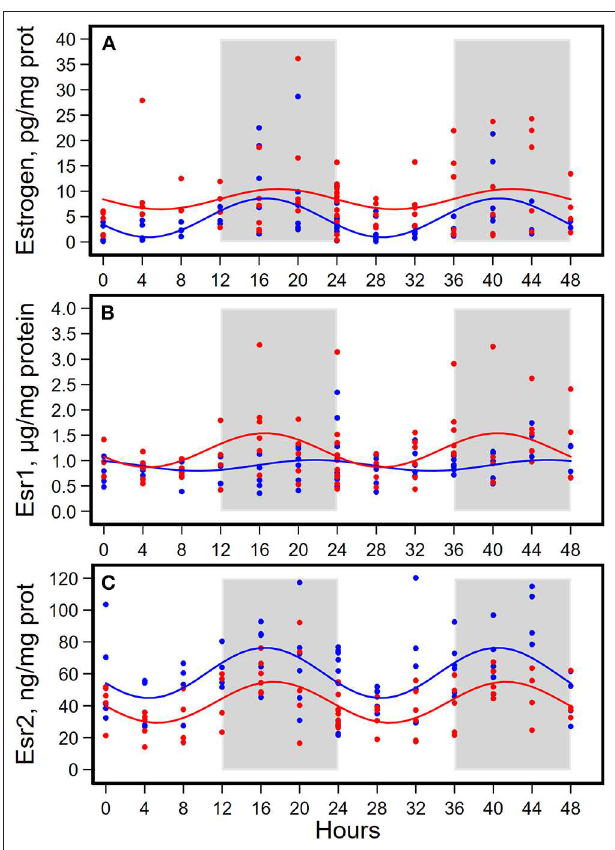
FIGURE 4 | Diurnal expressions of concentrations of estrogen (A) , estrogen receptor 1 (Esr1, B ), and estrogen receptor 2 (Esr2, C ) in mammary glands from pubertal mice fed AIN93G or high-fat diet ( n = 5 per time point per group). Open background: light phase; gray background: dark phase; blue circles and line: AIN93G diet; red circles and line: high-fat diet. The rhythm curves were generated by using the Cosinor model y = mesor + amplitude x Cos [2 π /24 ×